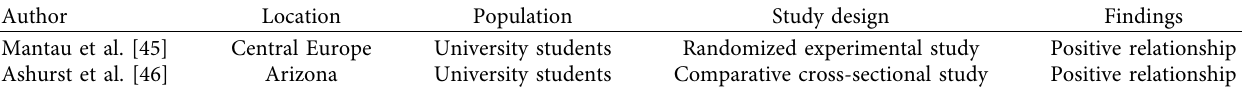
Table 2: Studies that report a relationship between negative emotions and hyperpalatable energy-dense food intake in food choices in